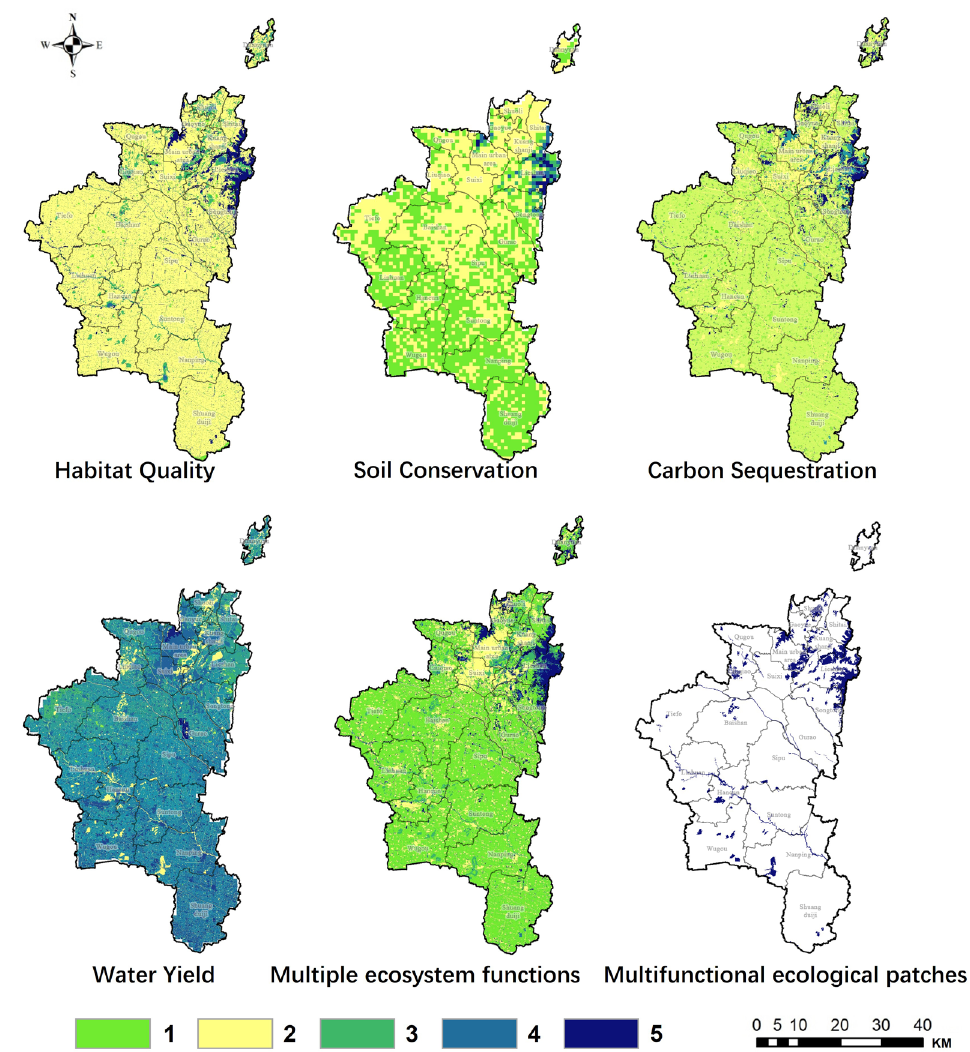
Figure 4. Spatial distribution of ecosystem service functions grades and multifunctional ecological patches in Huaibei City (Grade 1 = lowest; Grade 5 = highest).